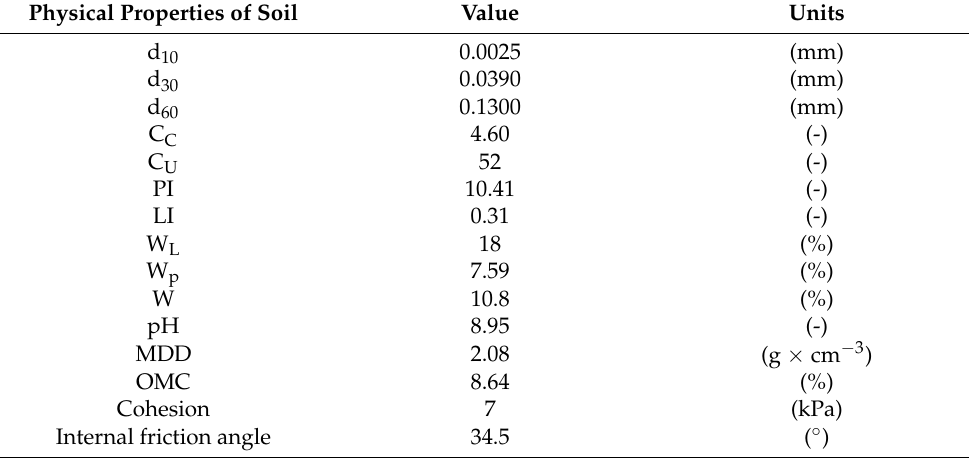
Table 1. Properties of the